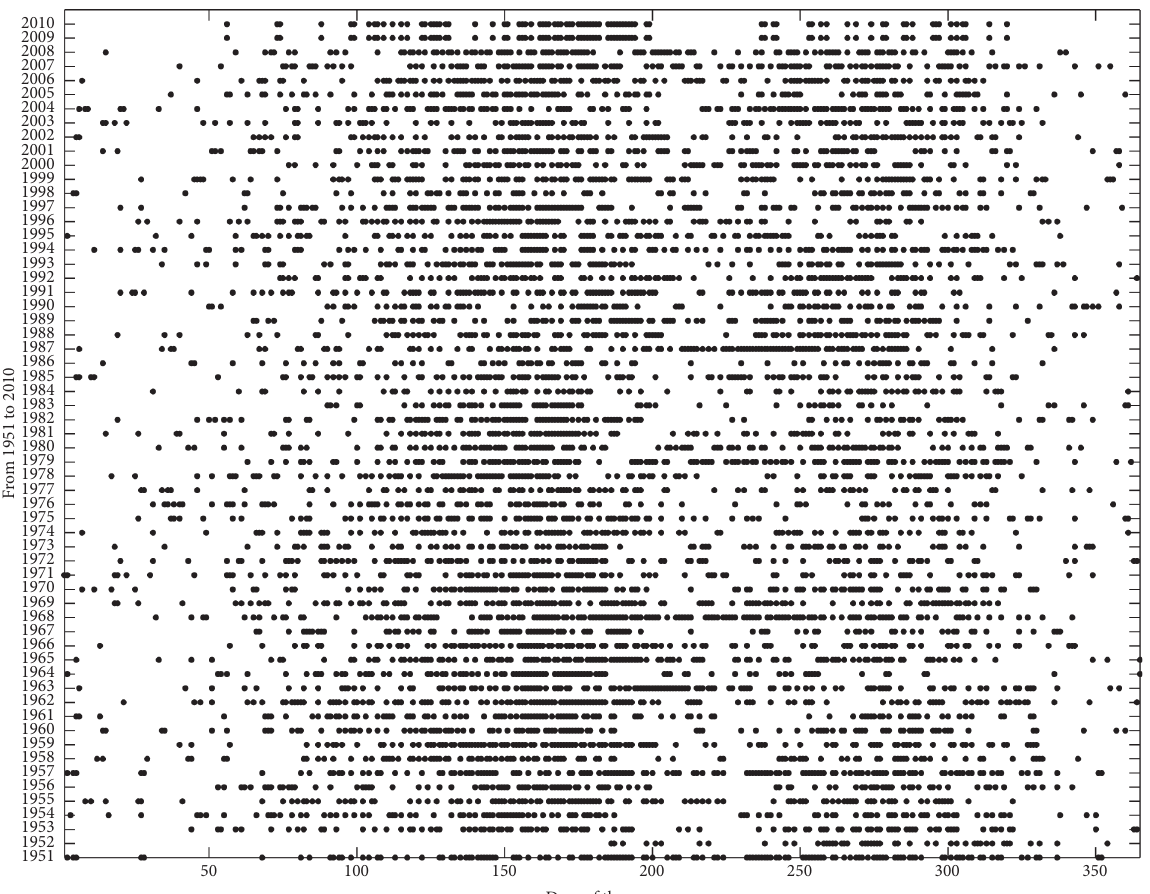
Figure 2: Daily rainfall occurrence during 60 years of observations in the Cotonou synoptic station. Each row corresponds to a year of observations. The occurrence of rain is defined by a precipitation threshold that distinguishes between dry and rainy days. The precipitation threshold chosen in this representation is